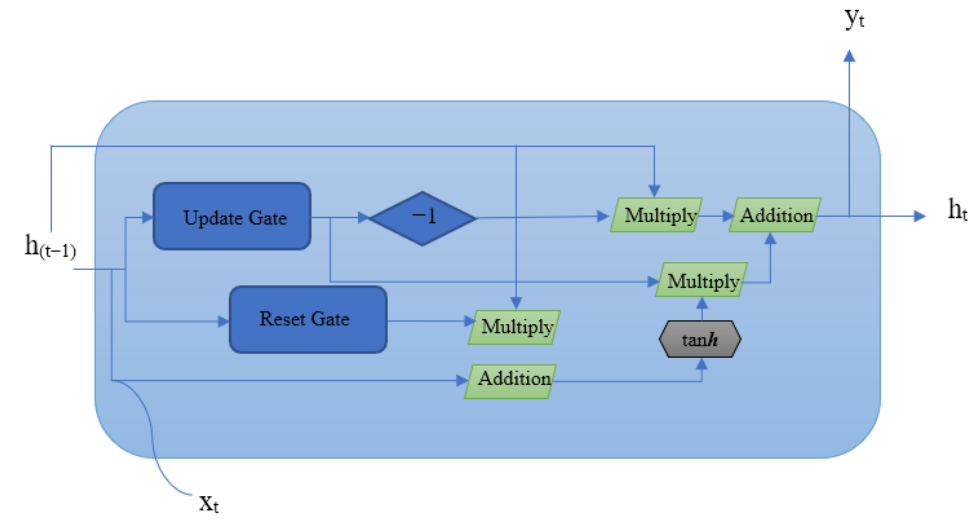
Figure 4. Operational diagram representing the functions of the GRU-based RNN model.